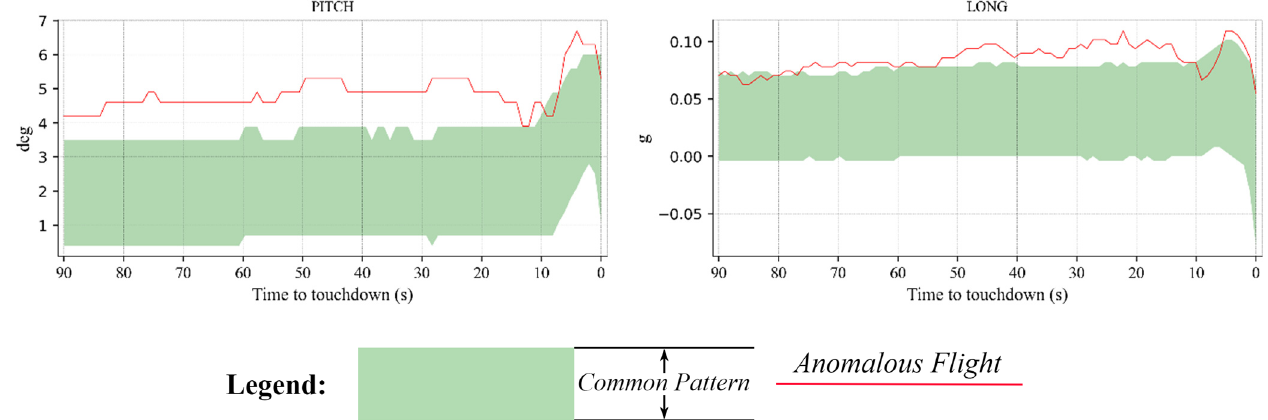
Figure 13. An example from the collection of anomalous flights that landed at the ZPPP airport.